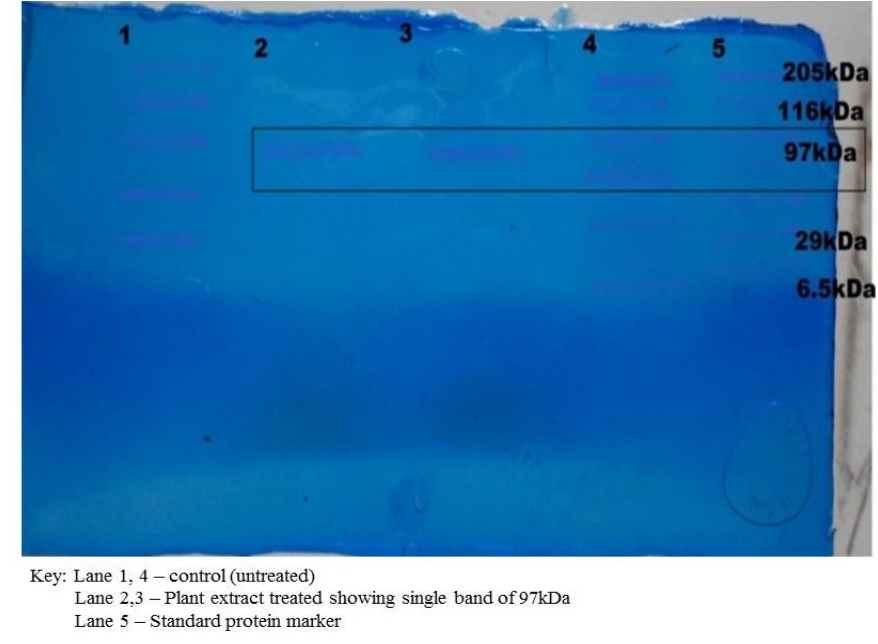
Figure 4. Protein analysis by SDS PAGE.